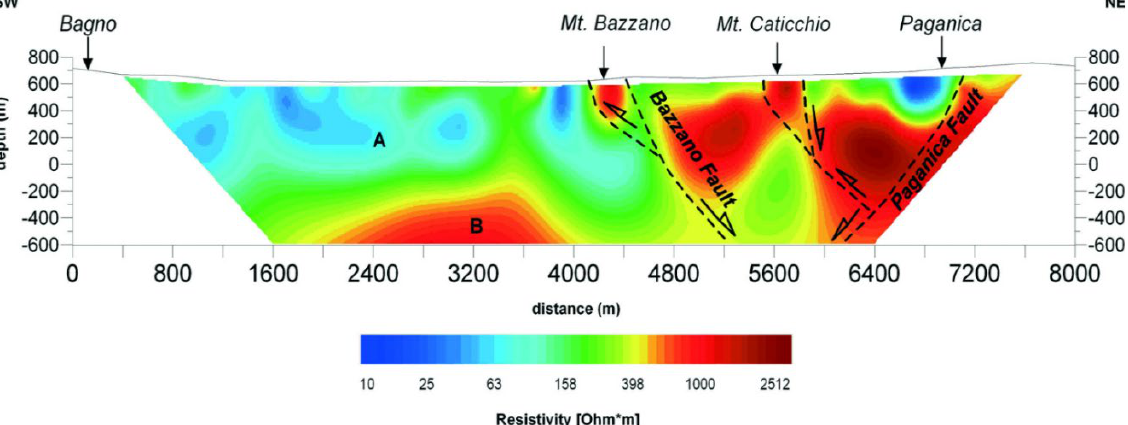
Figure 7. DERT image elaborated by the DCIP2D inversion code. Major features are labeled with letters. ( A ) represents alluvial deposits and the Messinian turbidite complex; ( B ) Unfractured calcareous block. The more resistive blocks are probably associated to Miocene units. Black dashed lines indicate presumed faults [36].